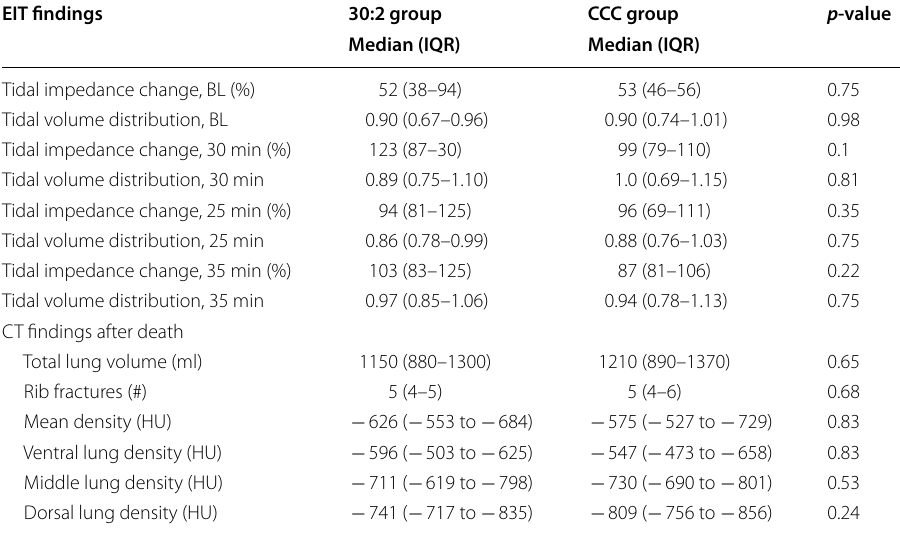
Table 3 Electrical impedance tomography and computed tomography